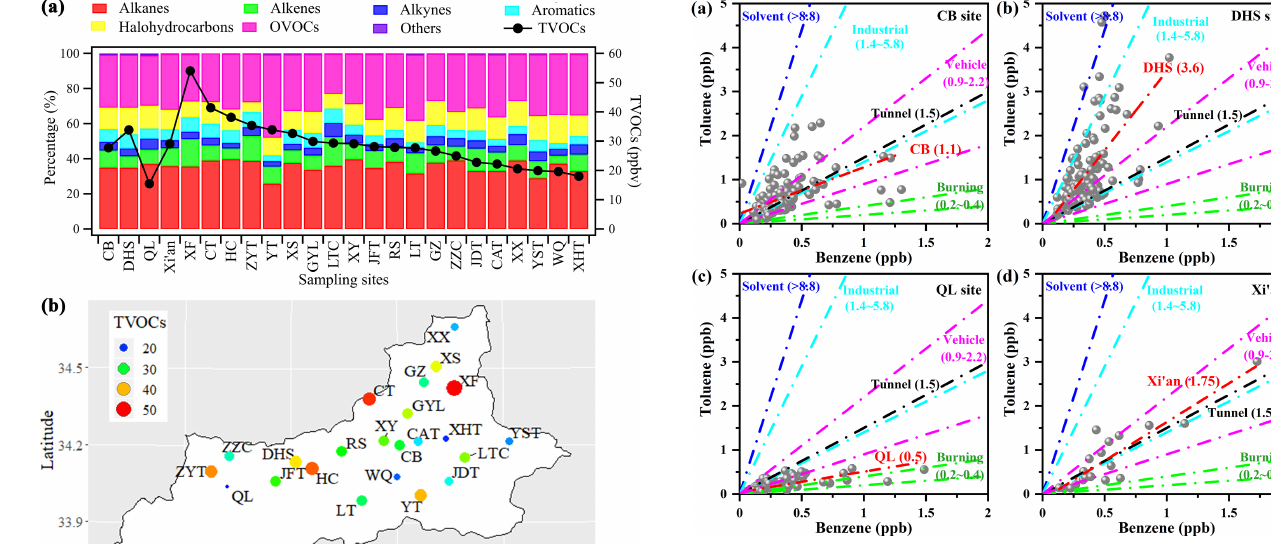
Figure 5. Linear correlations between toluene and benzene at the CB, DHS, QL, and gridded sampling sites between 03:00–07:00 during the observation